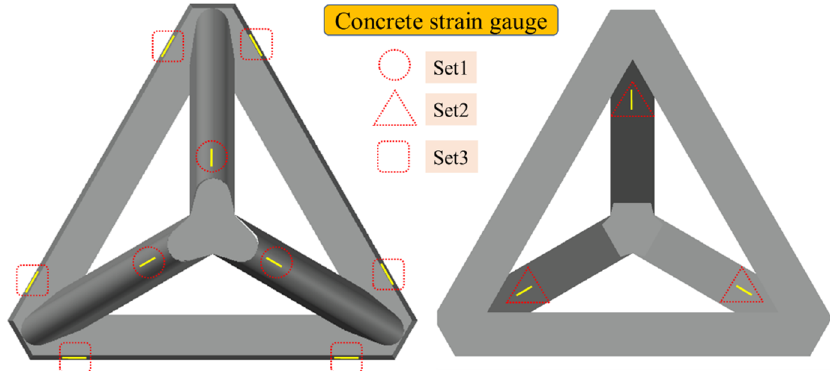
Figure 5. Arrangement of strain gauges bonded on surface of pervious frames.